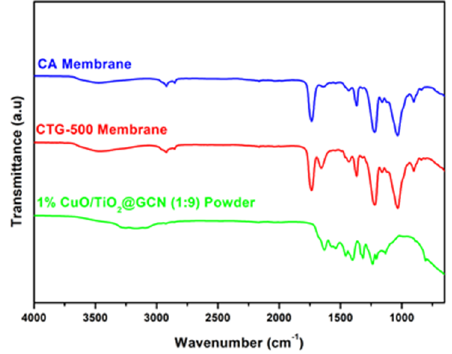
Figure 3. FTIR of CA membrane, CTG—500 membrane and 1% CuO/TiO 2 @GCN (1:9) powder.